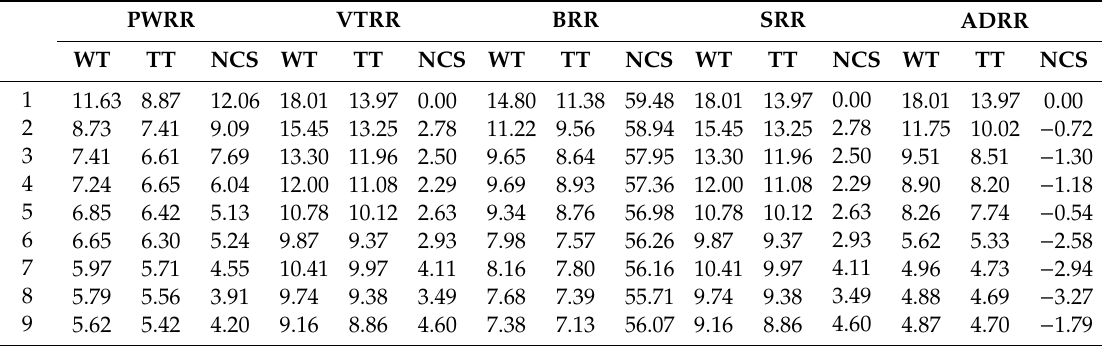
Table A3. Improvement percentages of the proposed algorithm over five scheduling